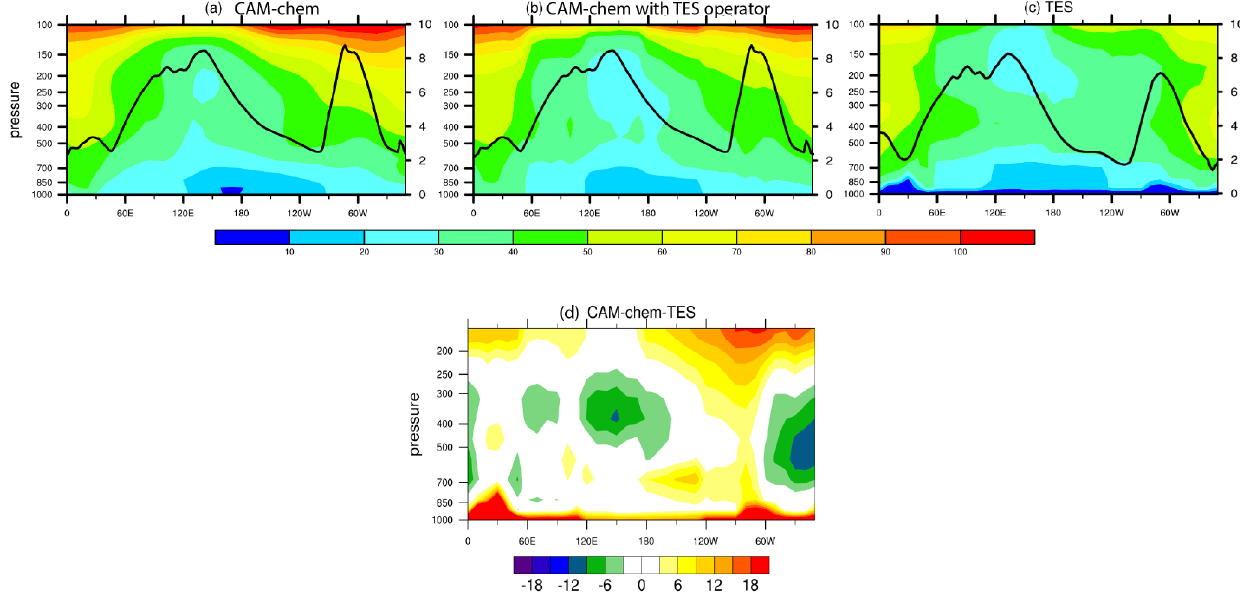
Figure 1. Climatology of tropospheric ozone (color, in ppb) during boreal winter (November–April) averaged between 10 ◦ S and 10 ◦ N for CAM-chem (a) , CAM-chem with TES operator (b) , TES (c) and difference between CAM-chem and TES (d) with precipitation (lines, right axis, in mmday − 1 ) from CAM-chem (a, b) and Tropical Rainfall Measuring Mission (TRMM) (c)